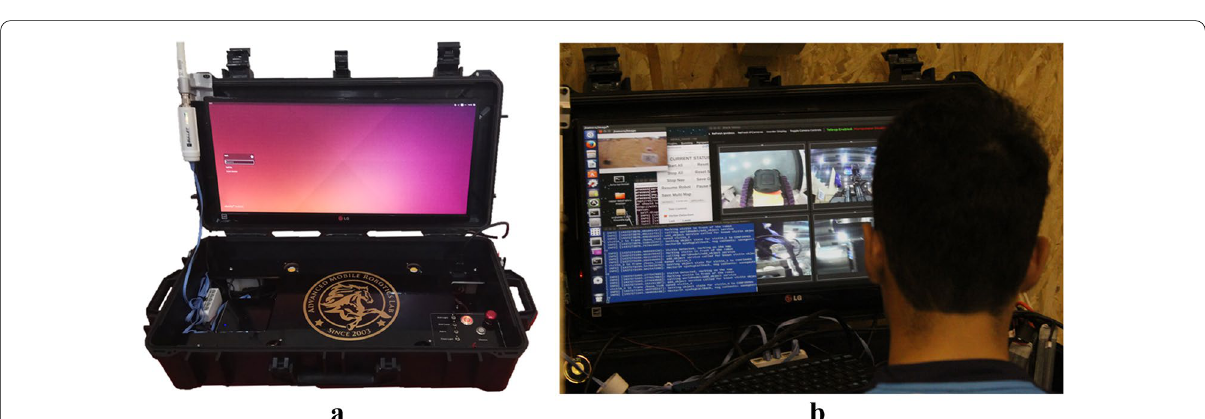
Fig. 15 a The operator control unit of the robot, and b the operating controlling the